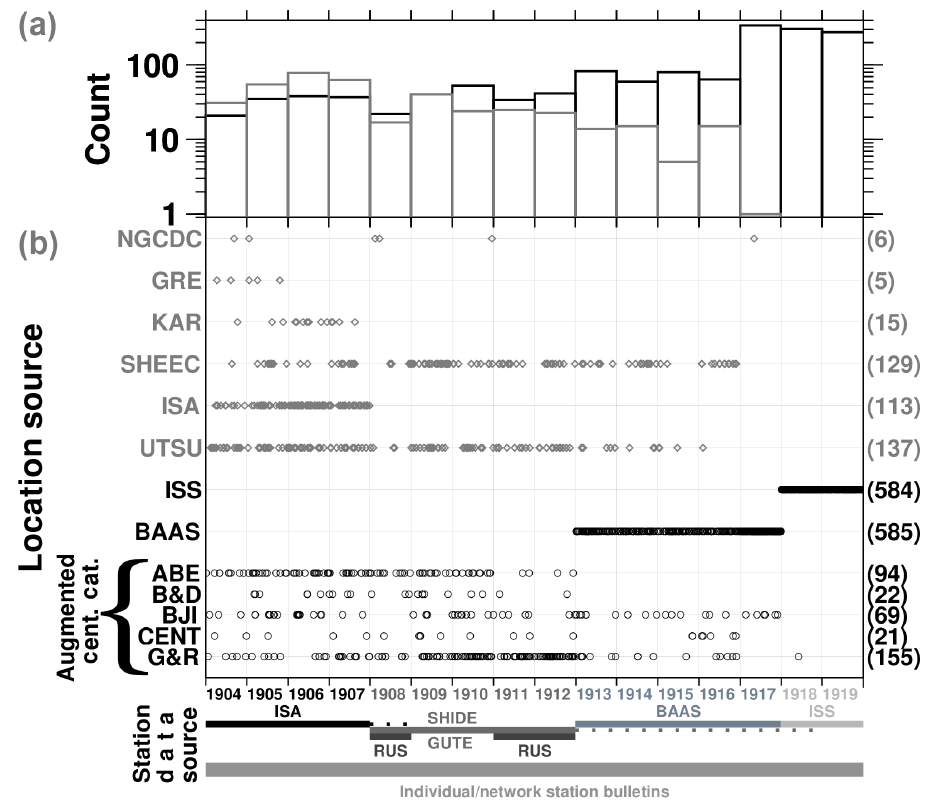
Figure 12. Timelines of the extension earthquakes already in our record (black circles) and added ones (grey diamonds) split by original location author/source. See text for the augmented Centennial Catalogue authors (black) and a brief descriptions of the additional location sources (grey). The total counts for each location source are shown on the right-hand side. The annual counts (a) of the extension earthquakes already known and added ones (black and grey histograms, respectively) are summarised. The station data sources (b) are also outlined and shown in different grey colours for the time ranges they have been used for (see text for details). For 1908 we have added station data from the “Kleinere Beben” part of ISA (black dots) and during 1913–1918 we also looked into the GUTE notepads for earthquakes not listed in the BAAS and ISS (dark grey dots). Individual/network station bulletins have been used to add both surface wave amplitudes and body-wave arrival times between 1904 and